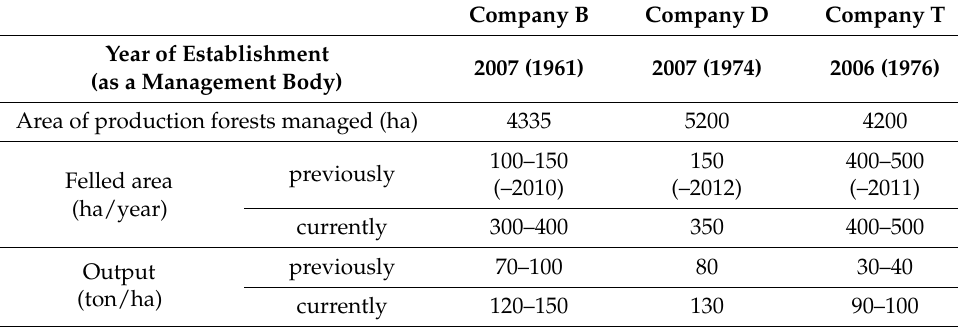
Table 2. Changes in acacia forest management, logging area, and production pertaining to the three forestry companies in Quang Tri